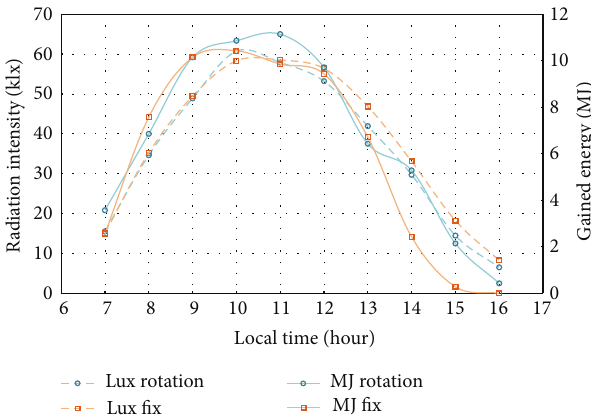
Figure 19: The hourly average values for the static system and for the system with